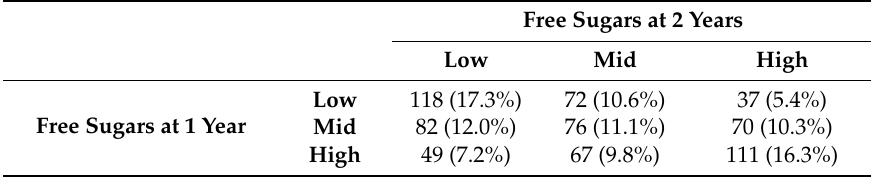
Table 4. Tertile of free sugars intakes from 1 to 2 years of age ( n = 682). Free Sugars at 2 Years Low Mid High Free Sugars at 1 Year